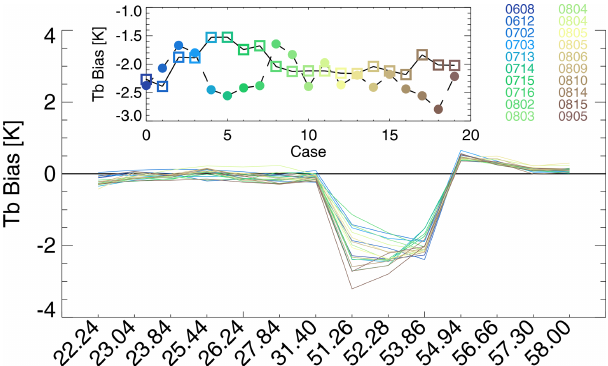
Figure A1. The T b bias offset for the cases used in this analysis. The inset plot shows the temporal variability of the 51.26 (filled circles) and 52.28 (open squares) GHz channels for these cases, where the colours indicate the date (MMDD) of the